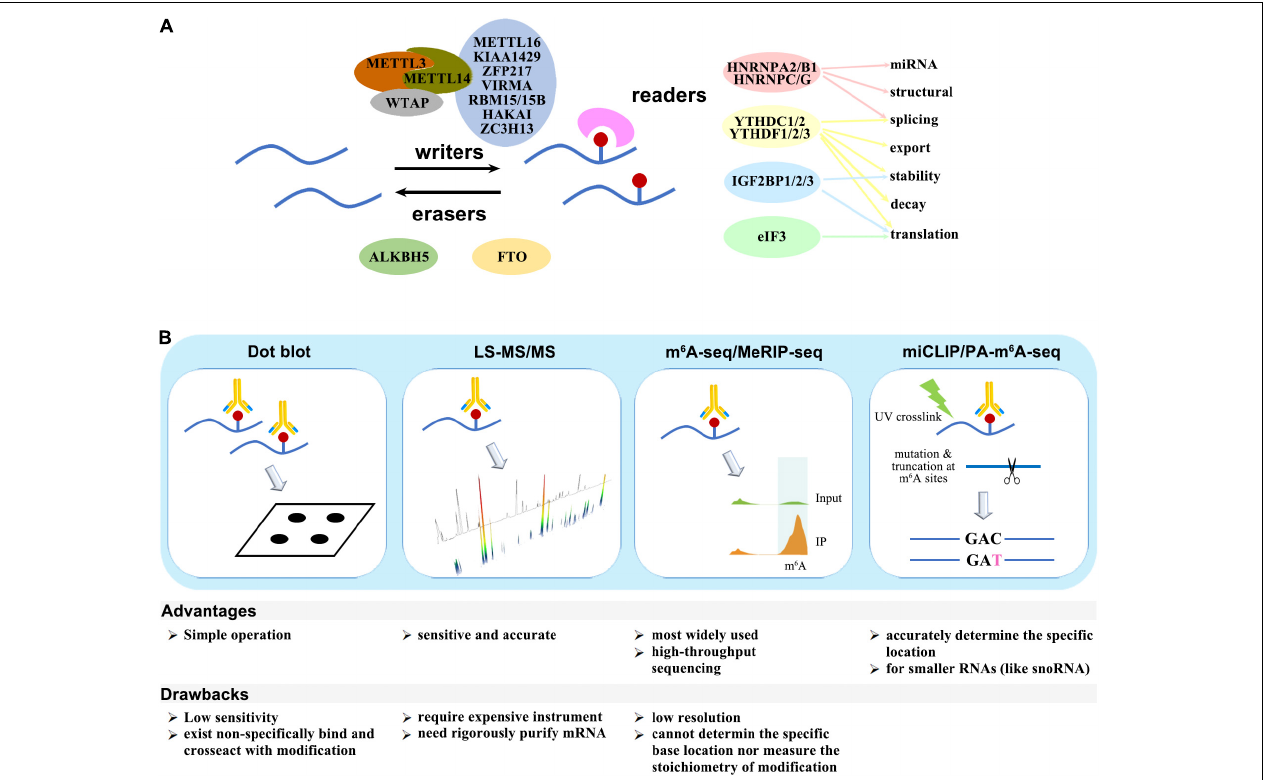
FIGURE 1 | (A) Writers, erasers, and readers of the m 6 A modification. (B) Schematic diagram of m 6 A detection